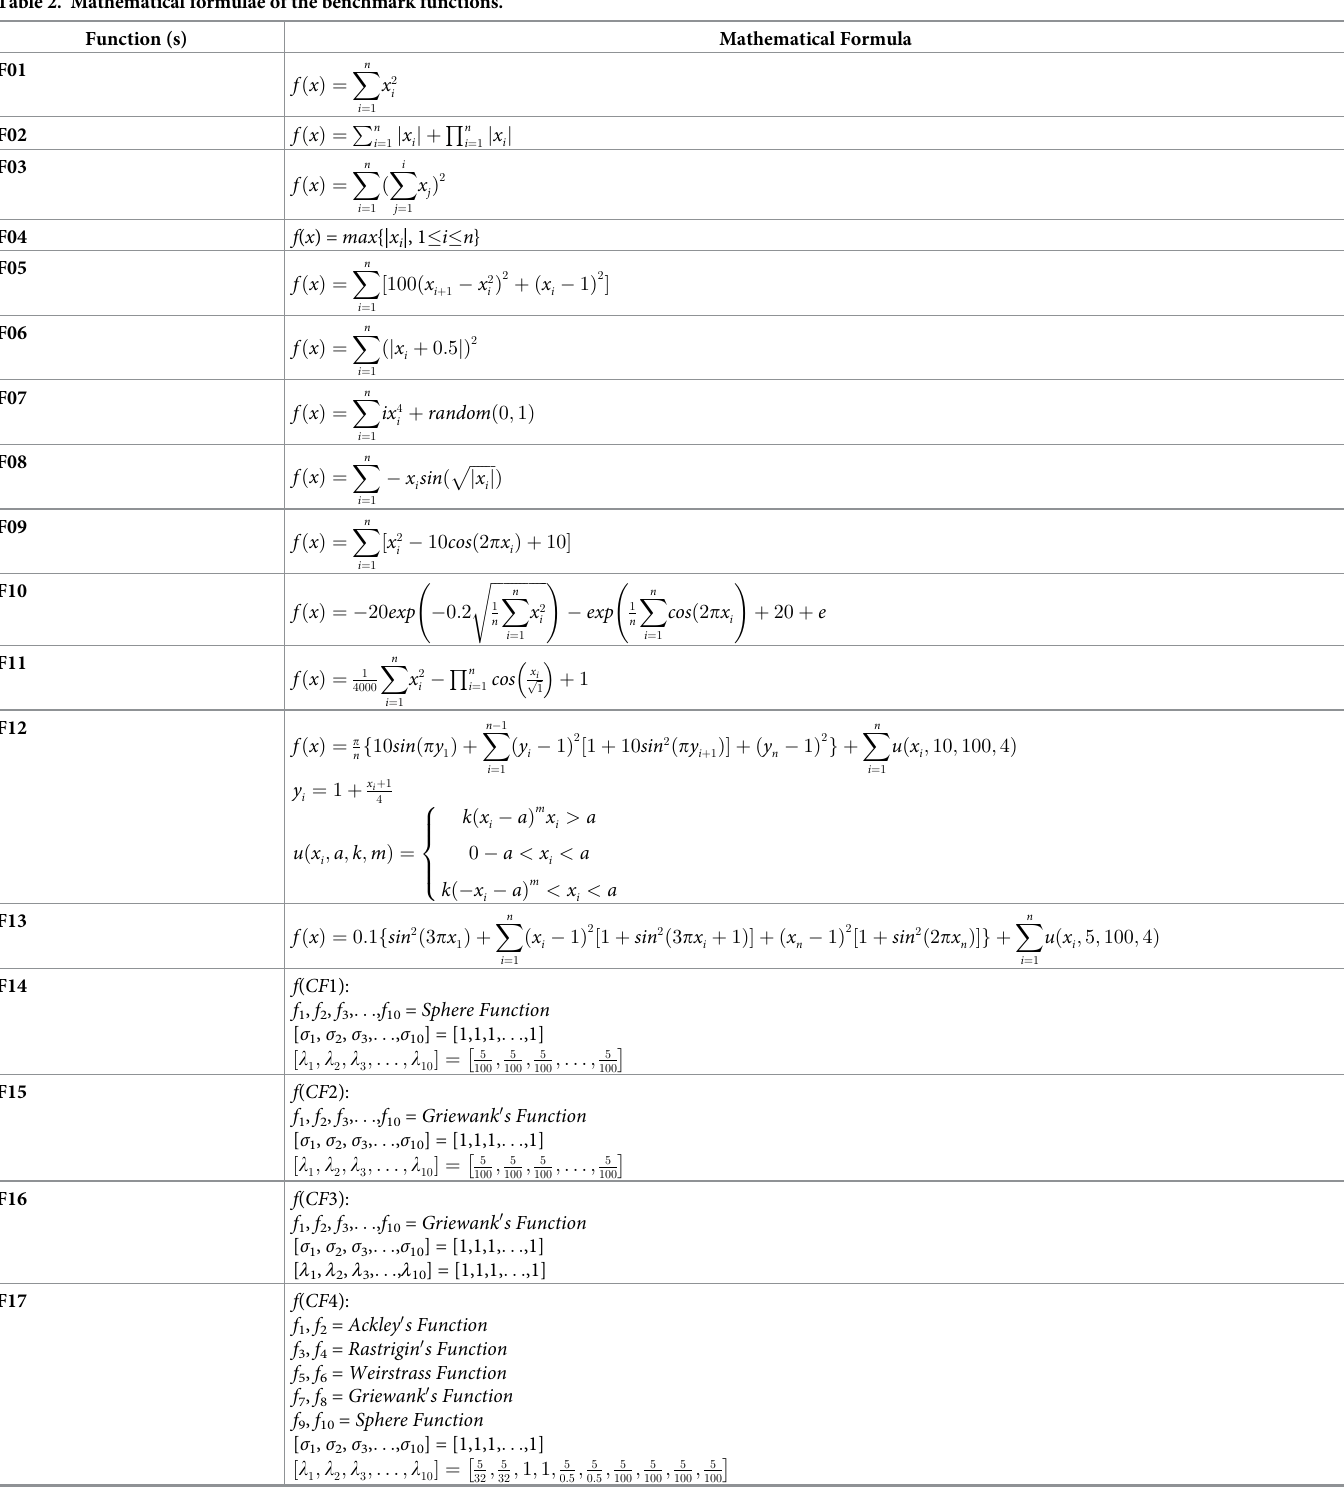
Table 2. Mathematical formulae of the benchmark functions. Function (s) Mathematical